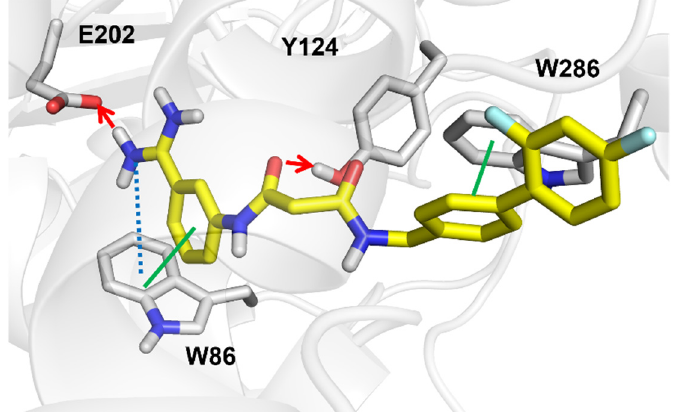
Figure 4. Zoomed in view at AChE binding site. The best 19h docked pose is rendered in yellow sticks. Red arrows and blue and green dashed lines indicate hydrogen bonds, cation– π , and π – π interactions, respectively.